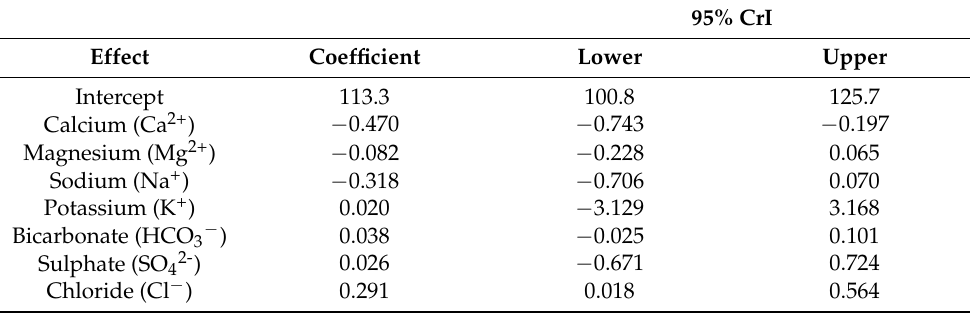
Table 3. Posterior means and 95% credible intervals for the regression coefficients of the spatial model involving minerals dissolved in spring water and coronary artery disease in